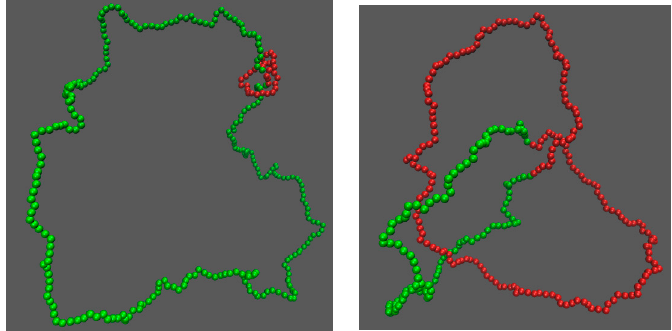
Figure 7. Simulation snapshots of the local knot ( left ) and the global knot ( right ) from the simulation {Yukawa potential, N m = 300, L p = 2.5 σ , κ − 1 = 5 σ , (cid:101) = 0.4 k B T }. The red beads correspond to knot cores, while the green beads correspond to unknotted region.